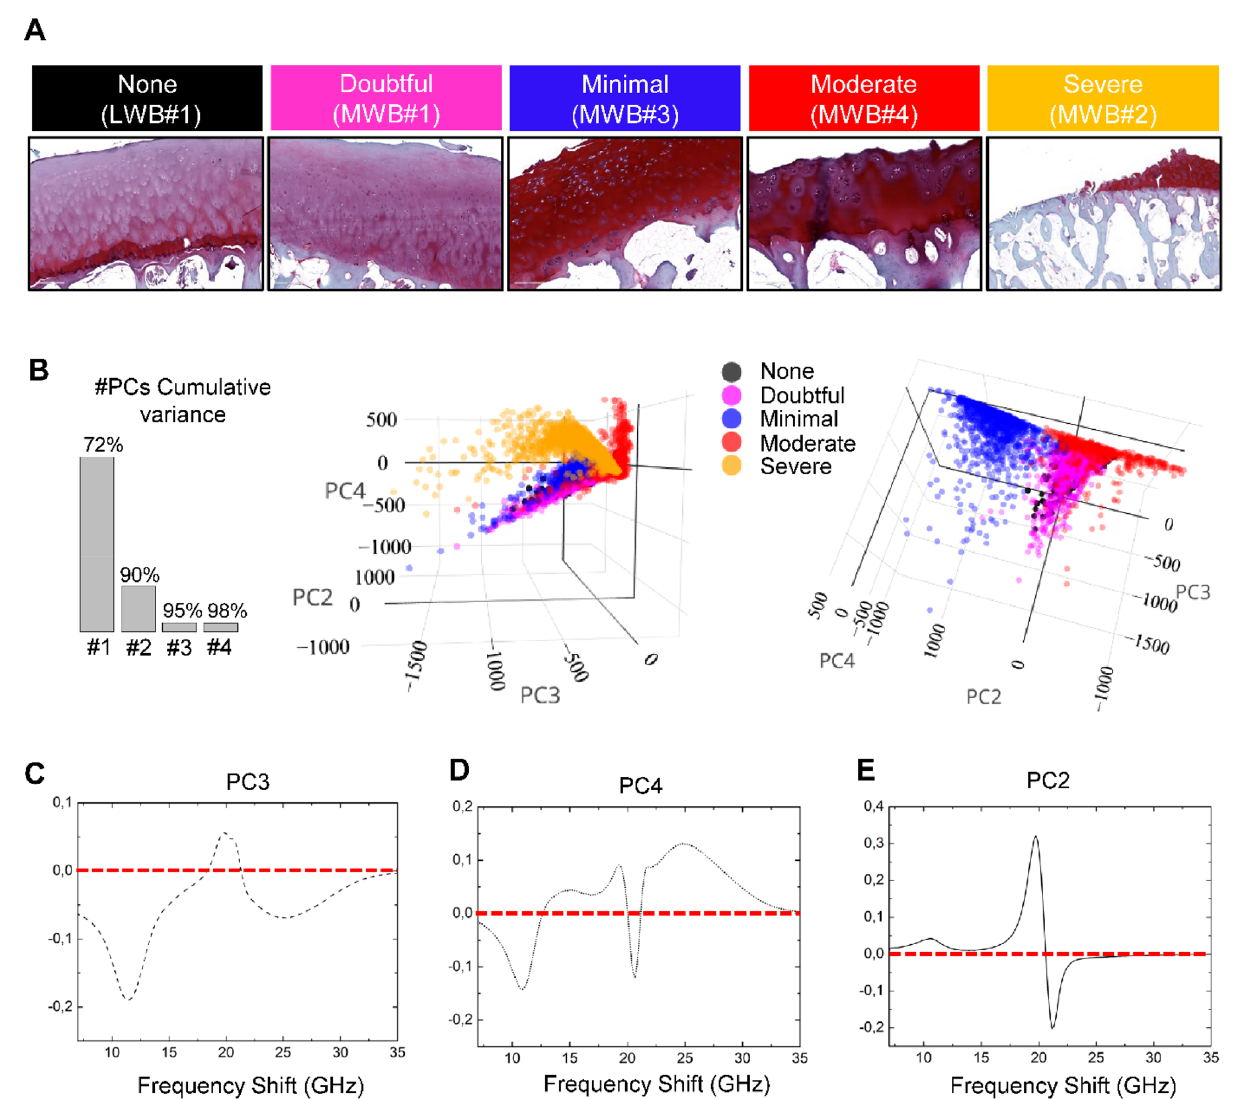
Figure 5. Principal component analysis of Brillouin spectra collected on the articular cartilage surfaces of MWB sections with different degrees of OA development. ( A ) Histological evaluation of OA progression in the articular surface of MWB sections of biopsy #1 to #4 ordered according to their increasing degeneration along with the healthy phenotype (LWB section of biopsy#1). ( B ) PCA scores plots of Brillouin spectra collected in the articular cartilage surface of the five sections, correspondent to the healthy phenotype (black) and four different grades of pathology severity, namely doubtful (magenta), minimal (blue), moderate (red) and severe (orange), along with the histogram reporting the values of PCs cumulative variance explained. PCA loadings plots of ( C ) the third (PC3), ( D ) the fourth (PC4) and ( E ) the second (PC2)